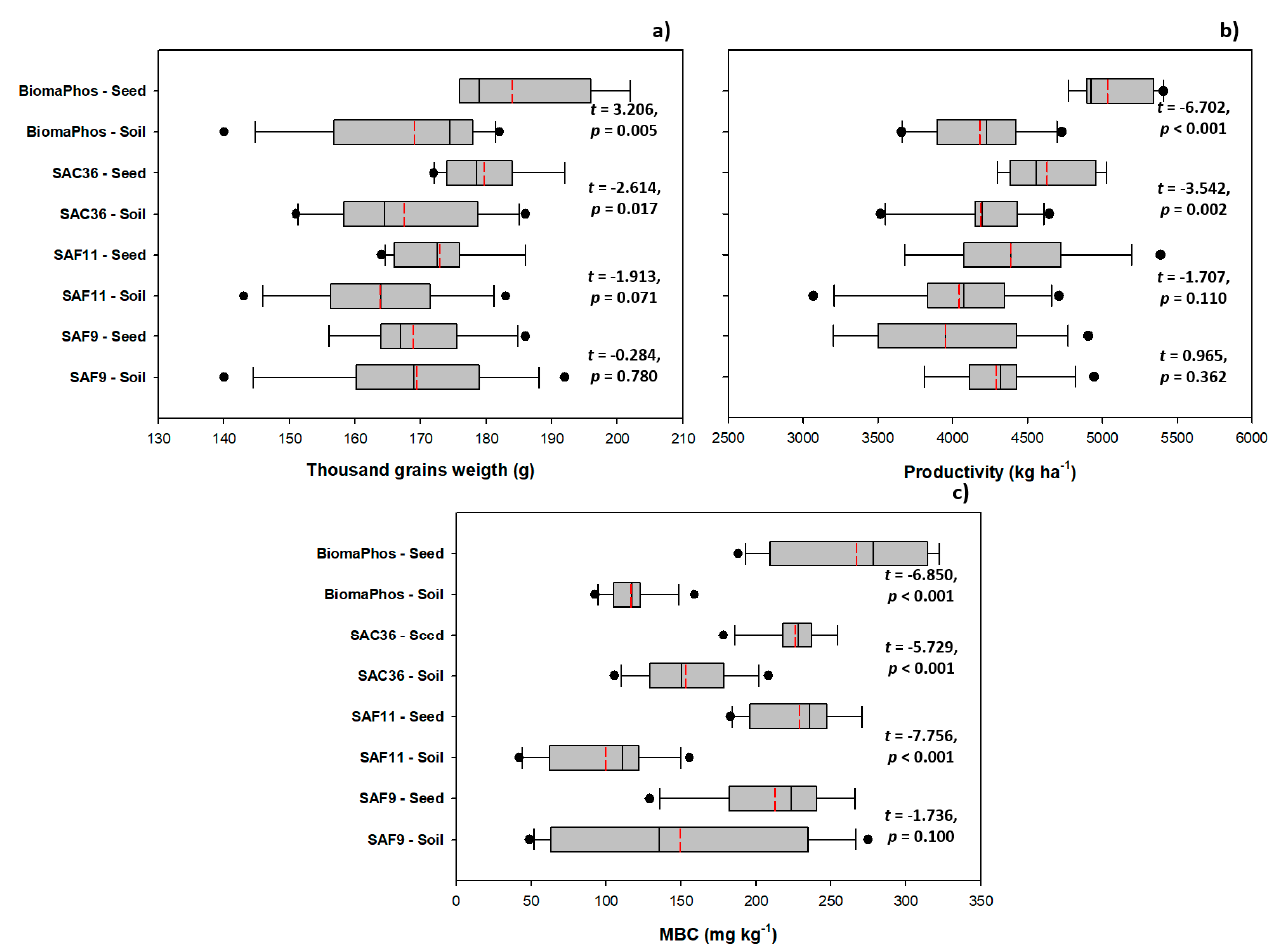
Figure 5. Effect of inoculation methods (via soil or seed treatment) of plant-growth-promoting rhizobacteria on thousand-grain mass ( a ), yield ( b ), and microbial biomass carbon (MBC) ( c ) sampled in the soil of Glycine max L. plants grown in summer 2019/2020 and 2020/2021, in five experimental soybean-growing fields in the interior of Goiás state, Brazil. SAF9, Brevibacillus sp.; SAF11, Brevibacillus sp.; SAC36, Bacillus velezensis ; BiomaPhos, Bacillus subtilis CNPMS B2084 (BRM034840) and Bacillus megaterium CNPMS B119 (BRM033112).